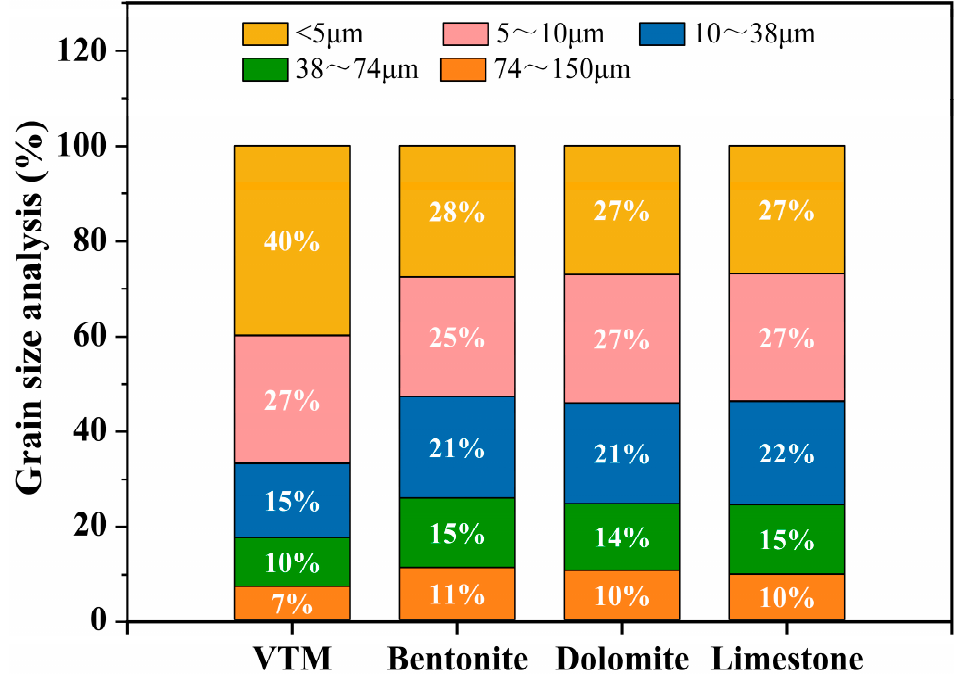
Figure 1. Grain size analysis of the raw materials. Table 2. Basic physical properties of bentonite.